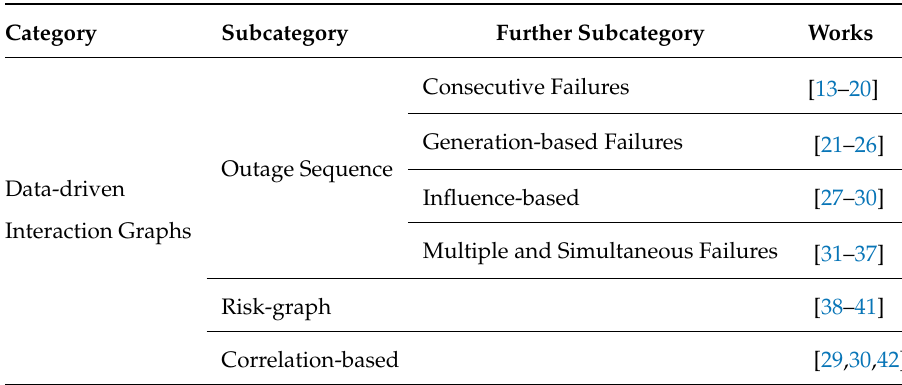
Table 1. Classification of existing studies using the data-driven